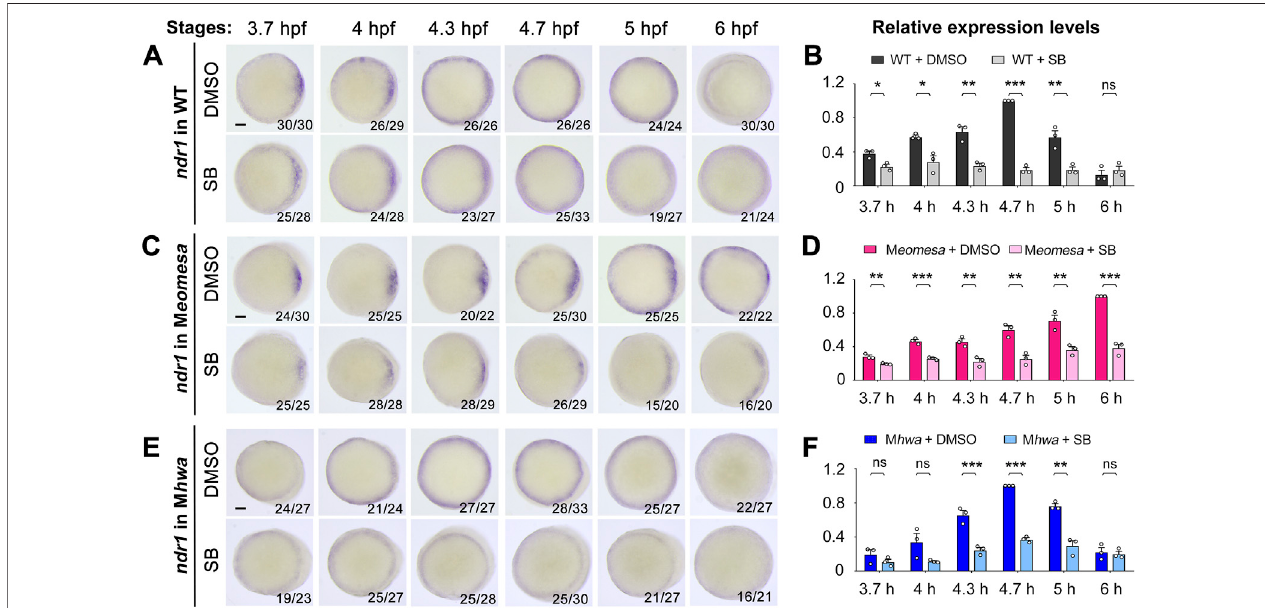
FIGURE 6 | Effect of Nodal signaling inhibition on ndr1 expression in WT and mutant embryos. WT, M eomesa or M hwa embryos at the one-cell stage were incubated in Holfreter ’ swater with 1%DMSO (control)or 50 μ M SB431542 (SB) and harvested at indicated stages for detection of ndr1 expression by WISH (A,C,E) or qRT-PCR analysis (B,D,F) . Embryos (A,C,E) were positioned in animal-pole view with dorsal tothe right if thedorsal side wasdistinguishable. Theratioofembryos with therepresentativepattern wasindicatedintherightbottom.Scalebars,100 μ m.qRT-PCRanalysiswasperformedusing15embryosper sample.Theexpression level at 3.7, 4, 4.3, 5 and 6 hpf in WT or M hwa embryos wasnormalized tothat at 4.7 hpf in WT embryo, while the expression level at different stages in WT or M eomesa embryos wasnormalized tothat at 6hpf inWT embryos. Error bars indicated S.D. based on three biological replicates (indicated bysmallcircles). Statistically signi fi cant